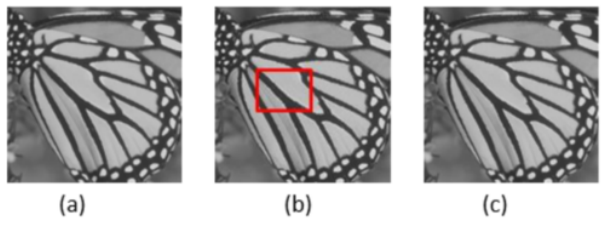
Fig. 12 Two-time reconstructed image Butterfly using two SR methods. (a) Input test image. (b) FCME. (c) Our